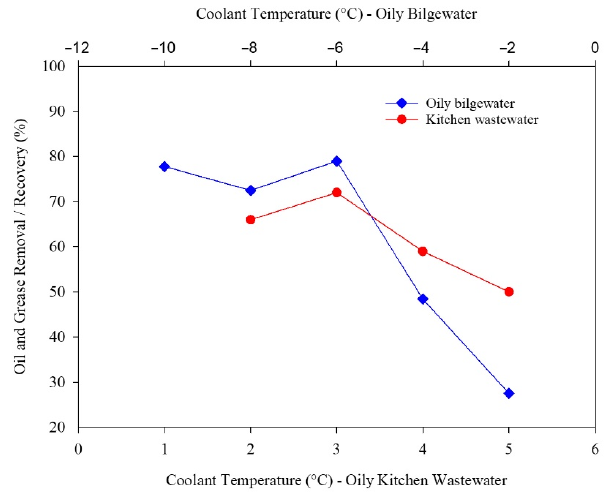
Table 3. Initial and final oil and grease values at different coolant temperature and p -values obtained Coolant Temperature, Sample